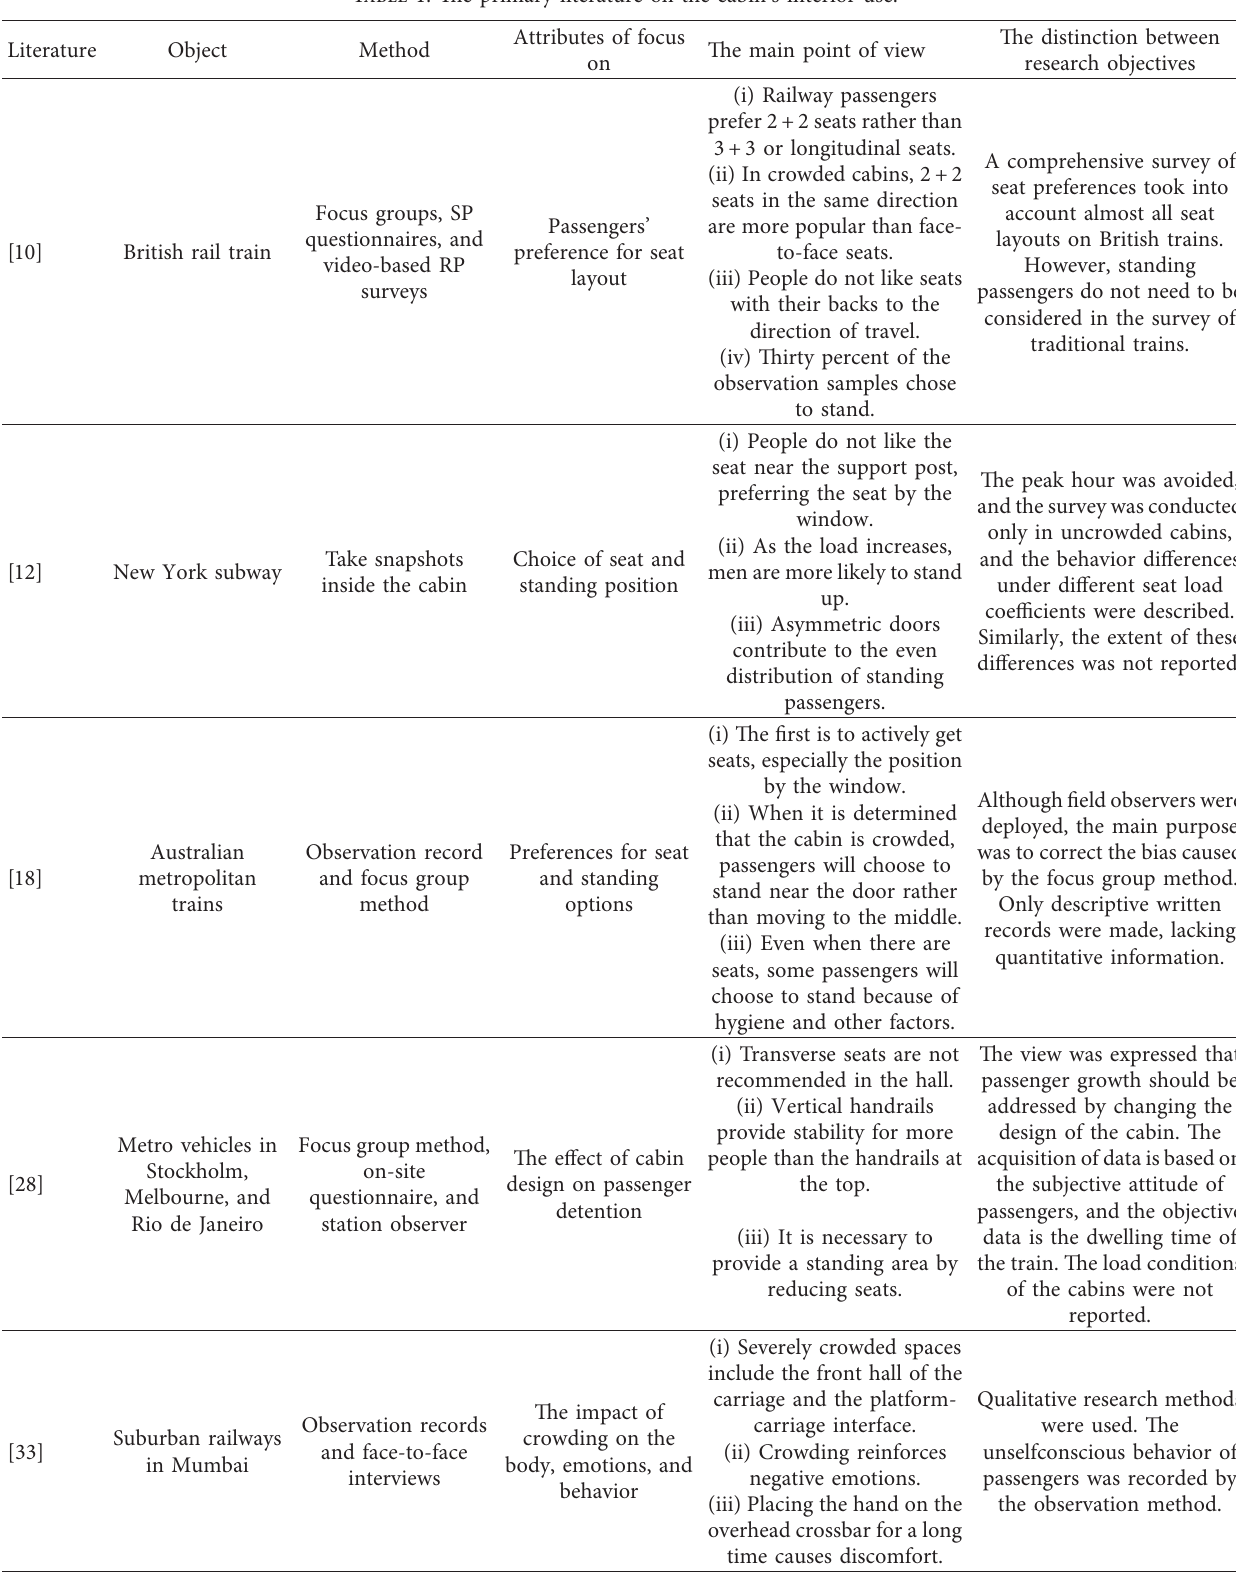
Table 1: The primary literature on the cabin’s interior